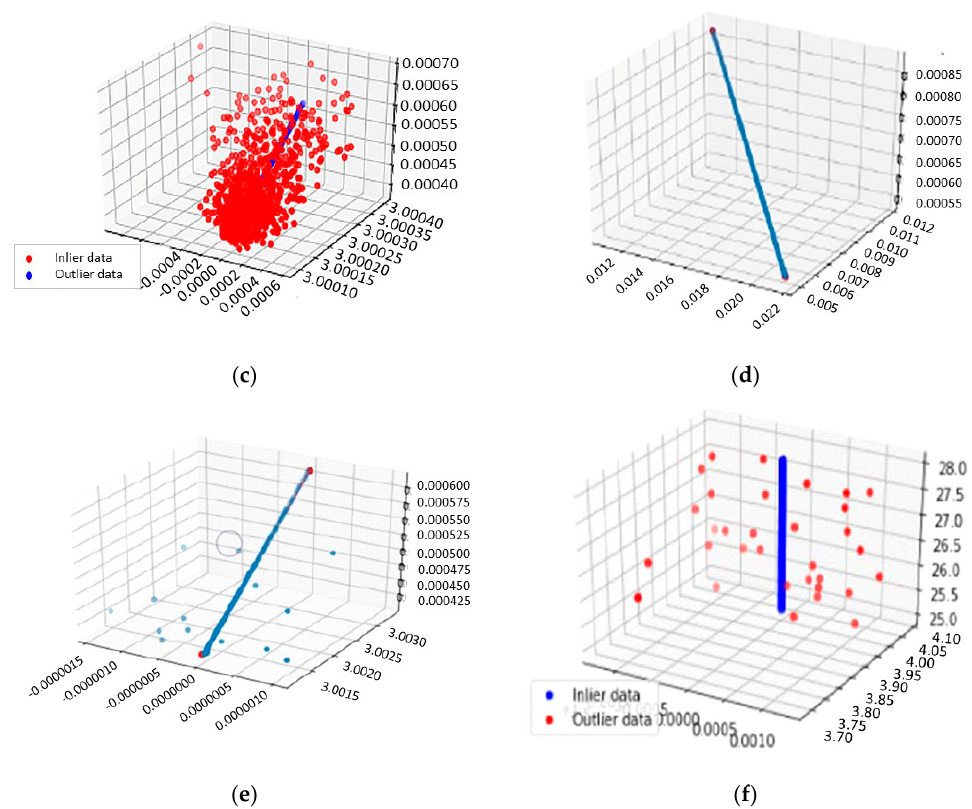
Figure 4. Results of the implementation of the first part of the algorithm to the simulation data. In ( a ) the original 3D point cloud, in ( b ) the same point cloud as projected on the image and in ( c ) the resulting point cloud after the rigid body transformation. In ( d ) the 2D edge of the inserted image is shown, in ( e ) shows the transformed 3D edge in the 3D space and in ( f ) the transformed edge is displayed.